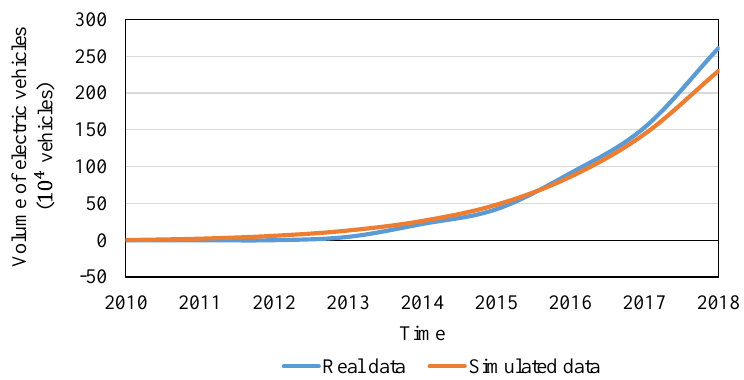
Figure 6. Compare the number of electric vehicles with real data and simulated data.